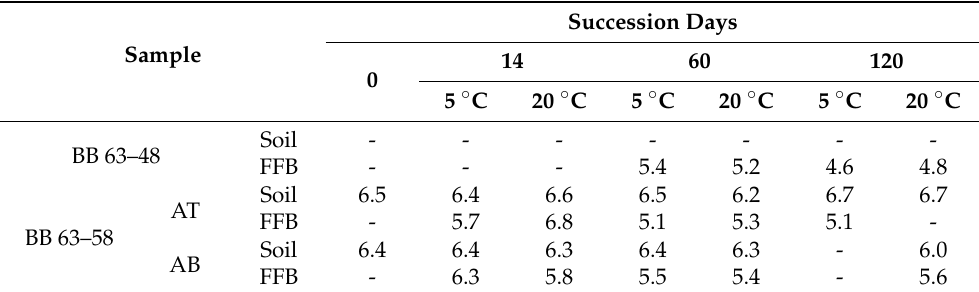
Table 4. Shannon Index calculated based on the number of sequences along the course of succession in the studied samples of Antarctic